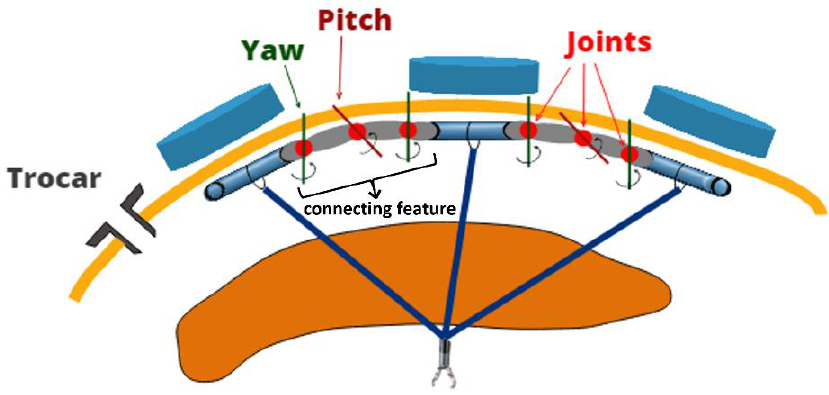
Figure 15. The proposed design concept of connecting the internal rod magnets to each other with joint allowing for yaw and pitch rotations.